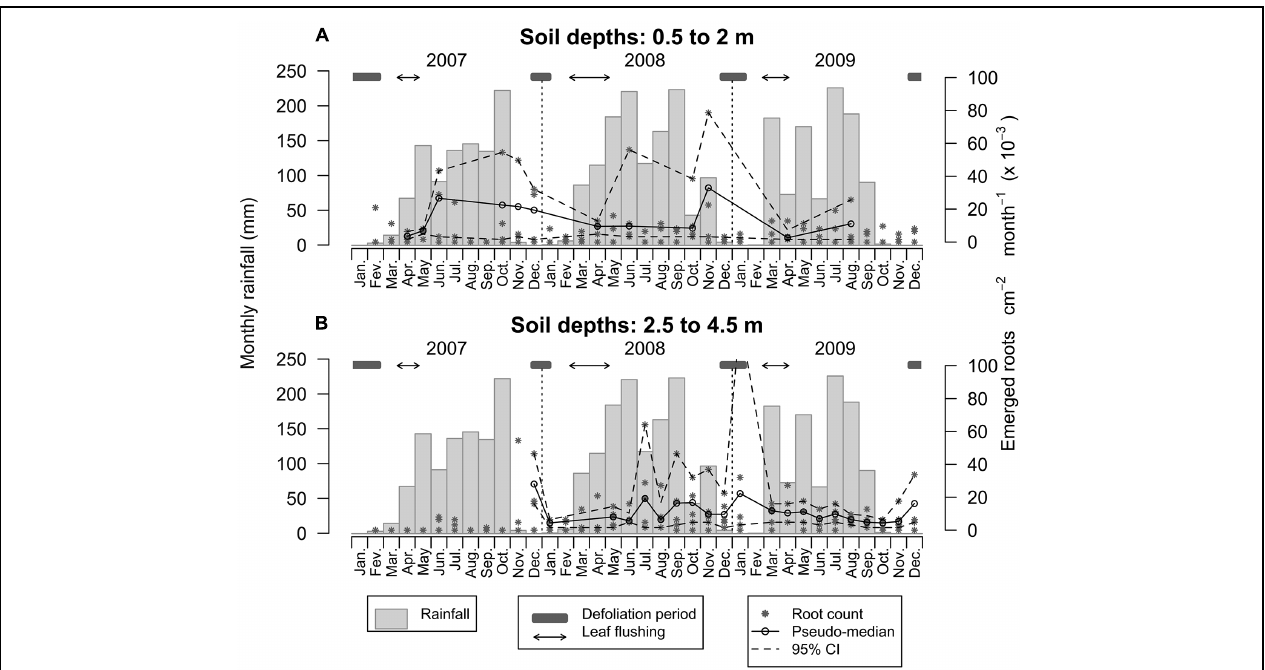
FIGURE 6 | Dynamics of root emergence over 3 years within the top 0.5–2.0 m of the soil profile (A) and between 2.5 and 4.5 m (B). Asterisks are emerging root counts determined in every root window at monthly intervals. Open circles represent the pseudo-median of emerging root counts in root windows ( n = 4 and n = 5 for the upper and lower plots, respectively) and dashed lines are 95% confidence intervals estimated using the Wilcoxon signed rank